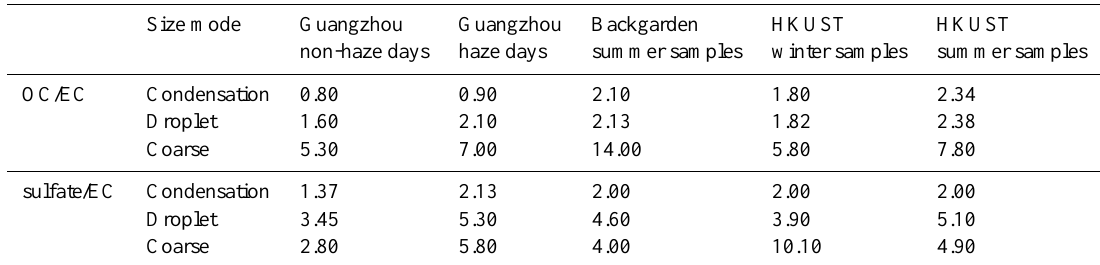
Table 3. The OC/EC and sulfate/EC ratios in three size modes. Size mode non-haze